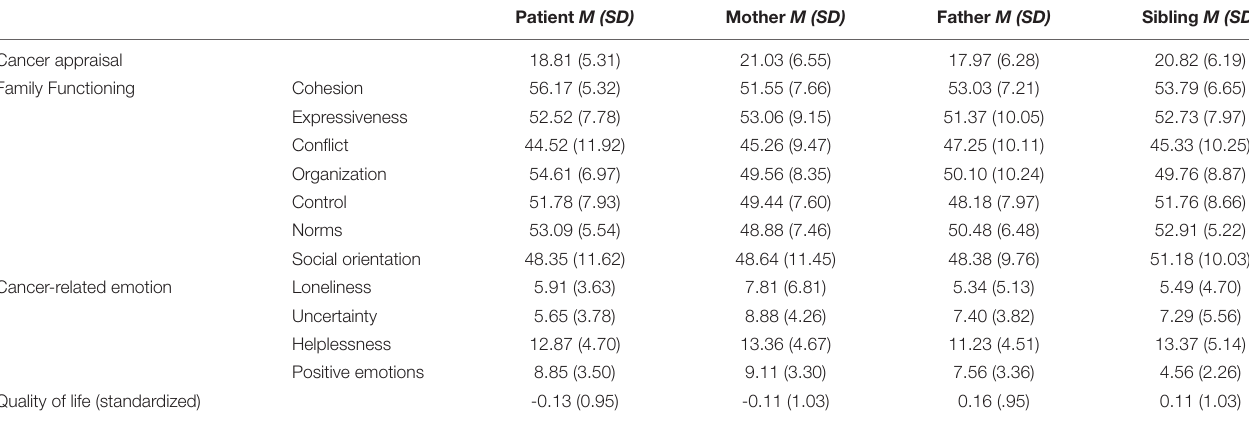
TABLE 5 | Mean scores for cancer appraisal (PSS scores), family functioning (FES subscale scores), cancer related emotions (SSERQ subscale scores) and quality of life (standardized PedsQL and MMQ scores) for the different family members. Patient M